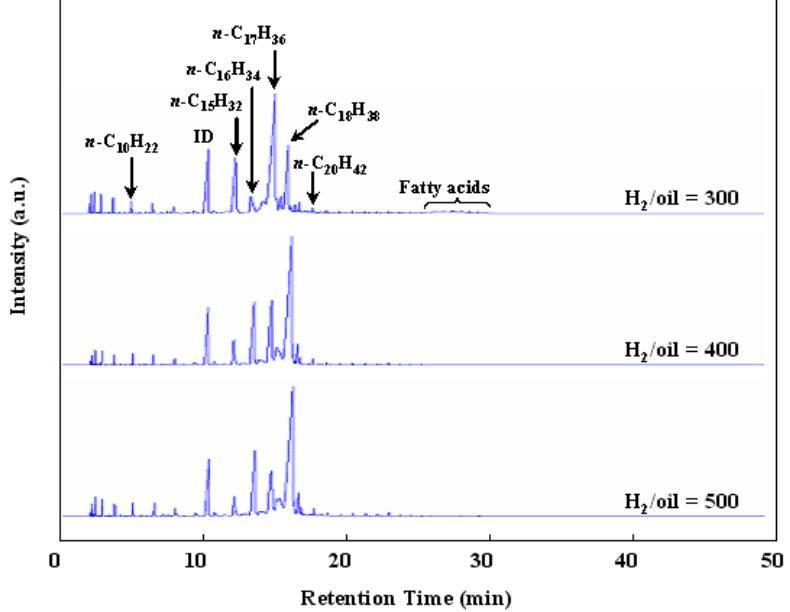
Figure 5. FID-GC charts of liquid products in the hydrotreatment of waste cooking oil over Ru/Al -Mont under various H /oil ratios ( T : 350 °C; H 13 2 space velocity (LHSV): 15.2 h –1 ).